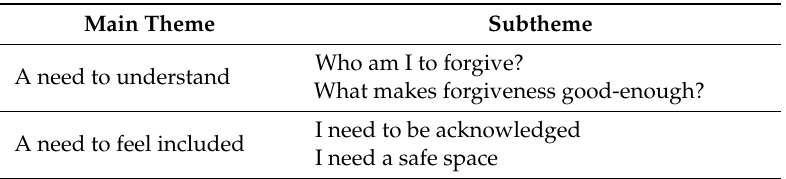
Table 1. Main themes and